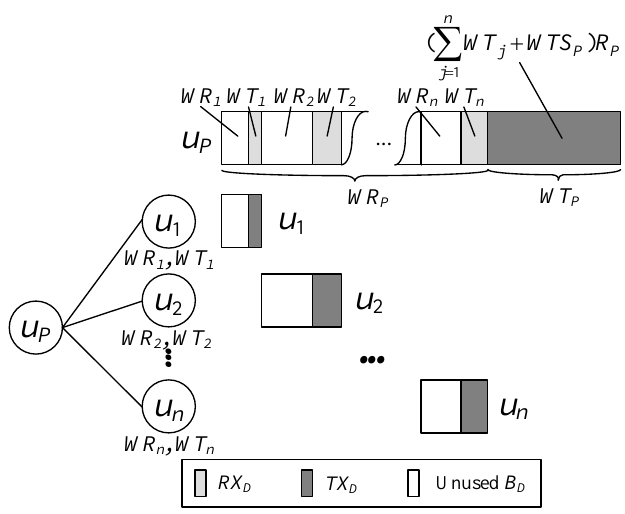
Figure 3. Scheduling for the data interval.